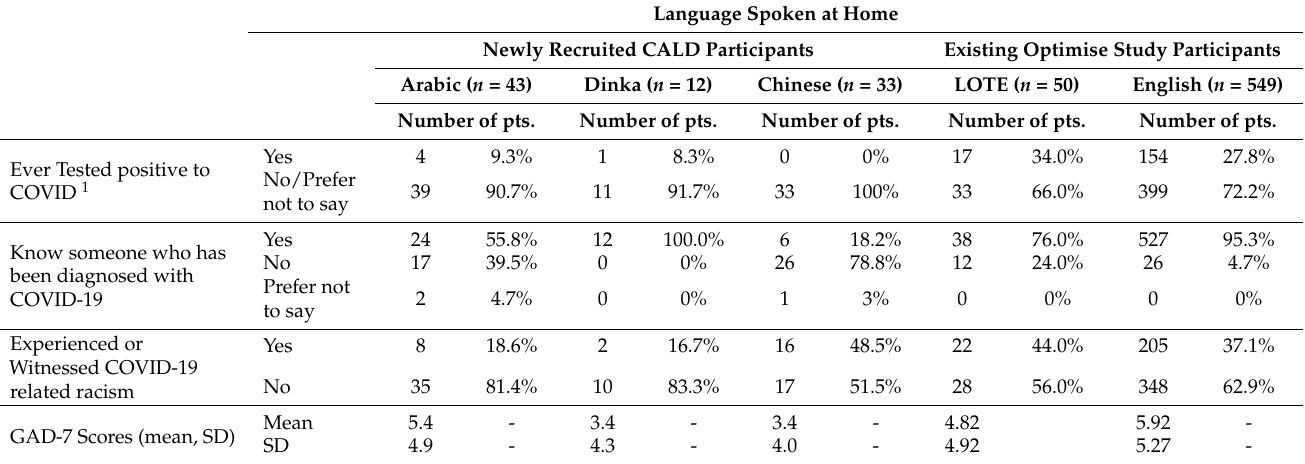
Table 3. COVID experiences by language group.